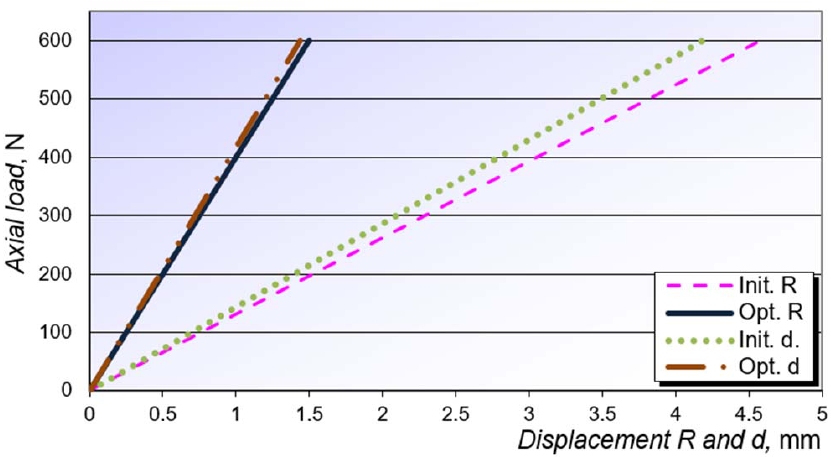
Figure 18. Comparison diagram of displacements at the place of fracture R and at the place of load for initial and optimized design.